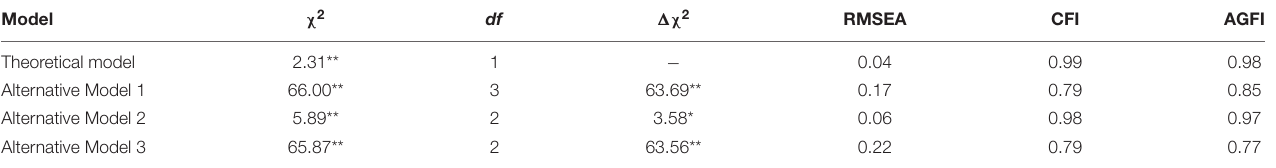
TABLE 3 | Comparison of structural equation models for employee’s psychological strain.